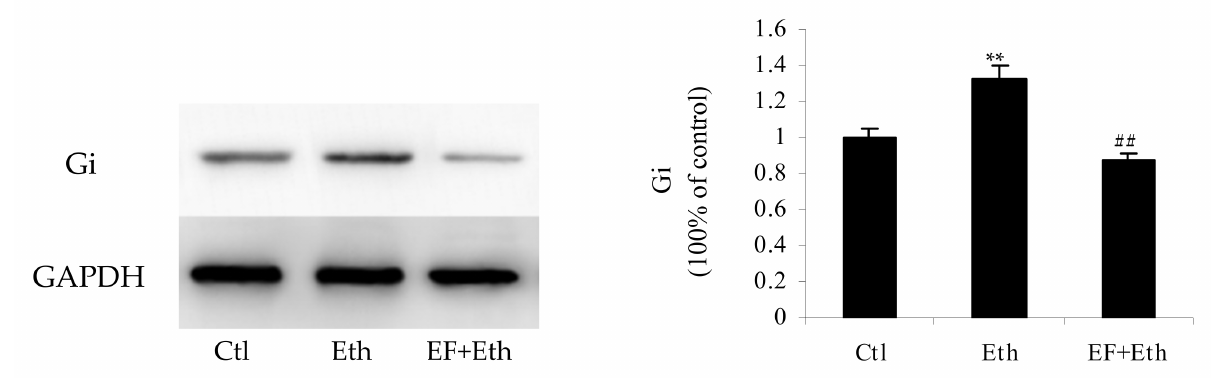
Figure 5. Western blot analysis of Gi protein. Ctl: control group; Eth: ethanol group; EF + Eth: flavonoids group. **: p < 0.01 (versus control group); ## : p < 0.01 (versus ethanol